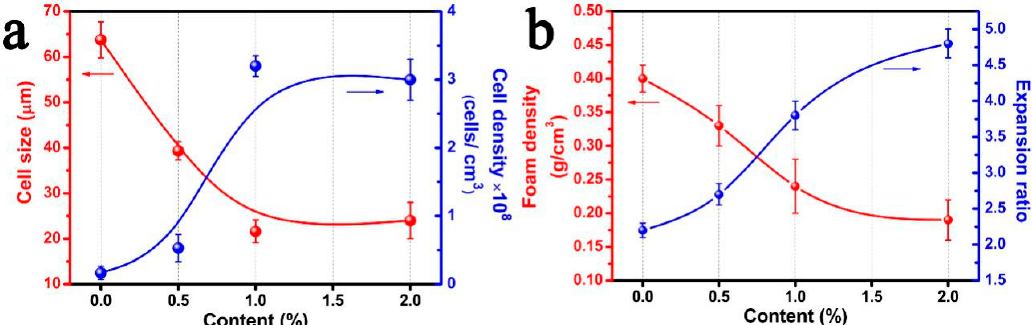
Figure 3. ( a ) Cell diameter and cell density, ( b ) Foam density and expansion ratio of neat PP, PP/FKM(0.5), PP/FKM(1.0), and PP/FKM(2.0) foams.